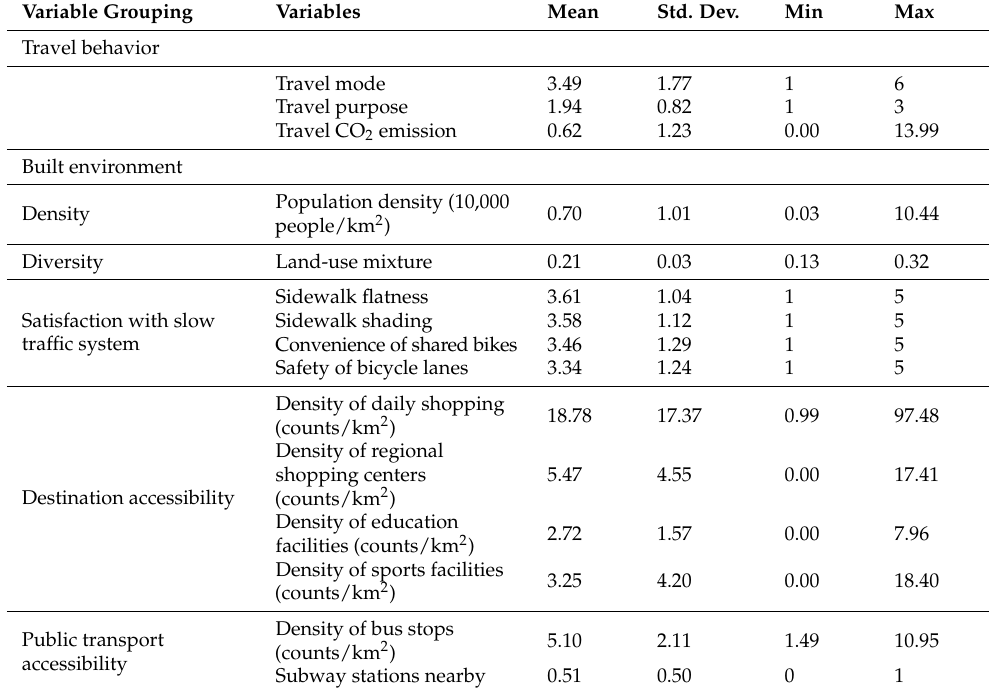
Table 5. Summary statistics of travel and built environment variables (N =